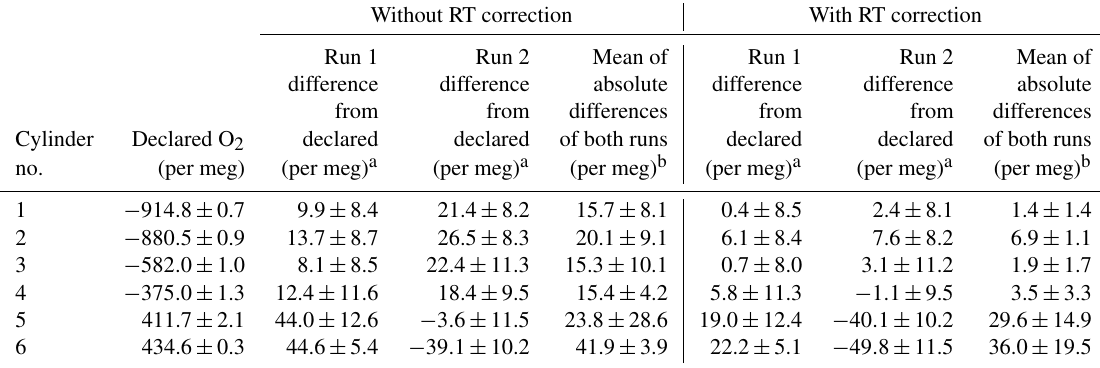
values of the Oxzilla and G2207- i under the partial drying regime for both O 2 , NC and O 2 , WC (Fig. 5b). With partial dry- ing, the time series of the difference between the O 2 values of the two analysers is a lot smoother than with no drying. This is due to the fridge trap removing some of the natural vari- ability in the water vapour mole fraction. Over the entire par- tial drying period the average difference between the Oxzilla observations and the G2207- i O 2 , NC is − 7144 . 1 ± 258 . 6 per meg. The average difference between the Oxzilla and